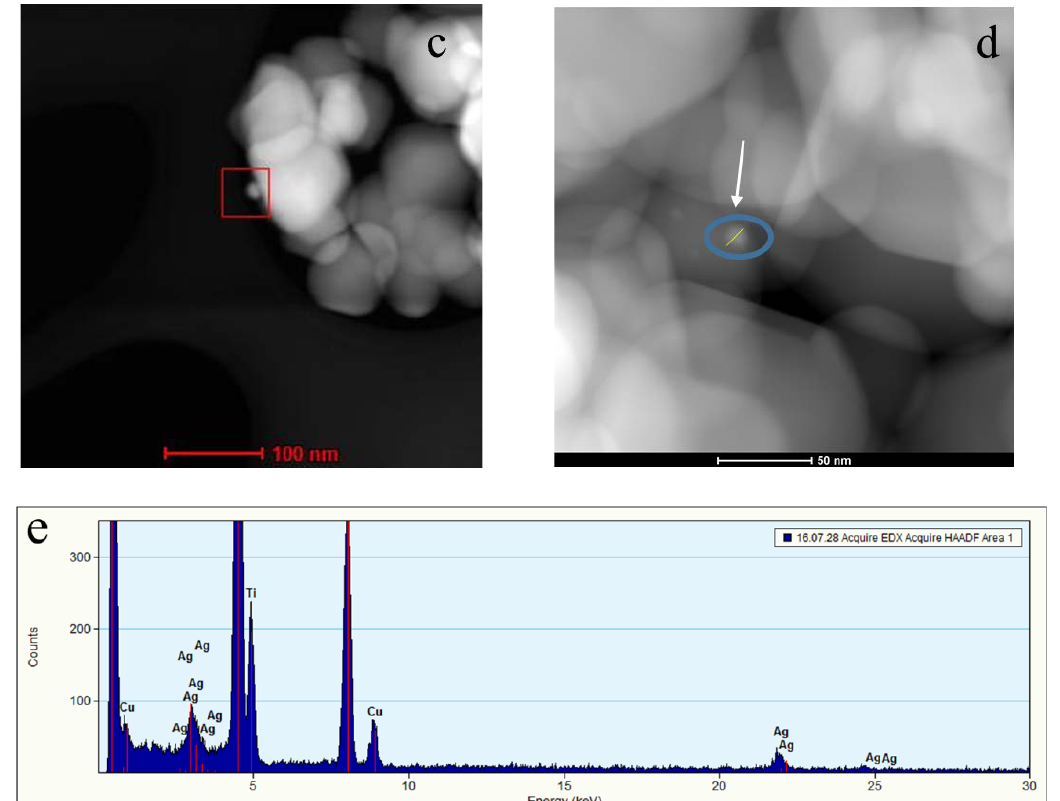
Figure 9. ( a ) DRS and ( b ) DRX of TiO 2 and TiO 2 decorated with NPs; TEM of ( c ) TAg0.1 and ( d ) TAg1; ( e ) EDS of TAg0.1. The optical properties of TiO 2 -Au composites can be investigated by diffuse reflec- tance UV-Vis spectroscopy, because the LSPR peaks of AuNPs are very sensitive to size